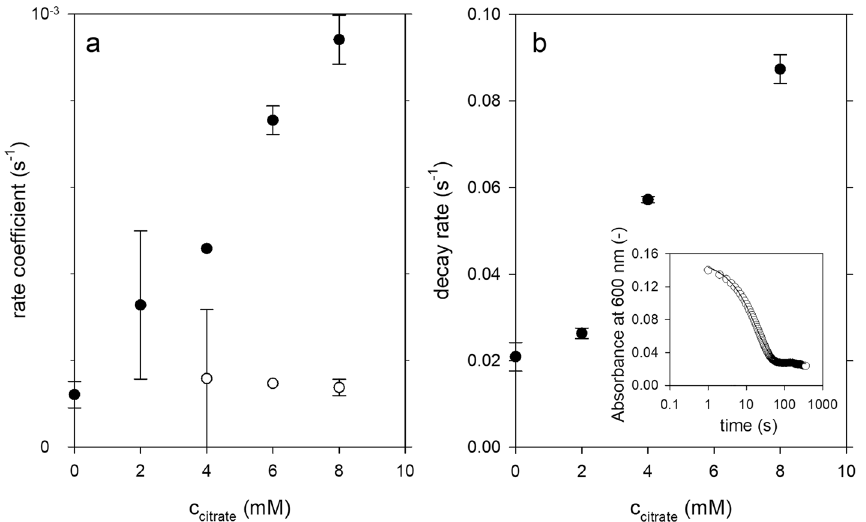
Figure 5. Rates determined from the swelling curves ( a ) and SDS-turbidity experiments ( b ) of CMPs at pH 8 as a function of the citrate concentration used to prepare the particles. Closed symbols in ( a ) correspond to the rate coefficient of swelling step 1 and open symbols correspond to the rate coefficient of swelling step